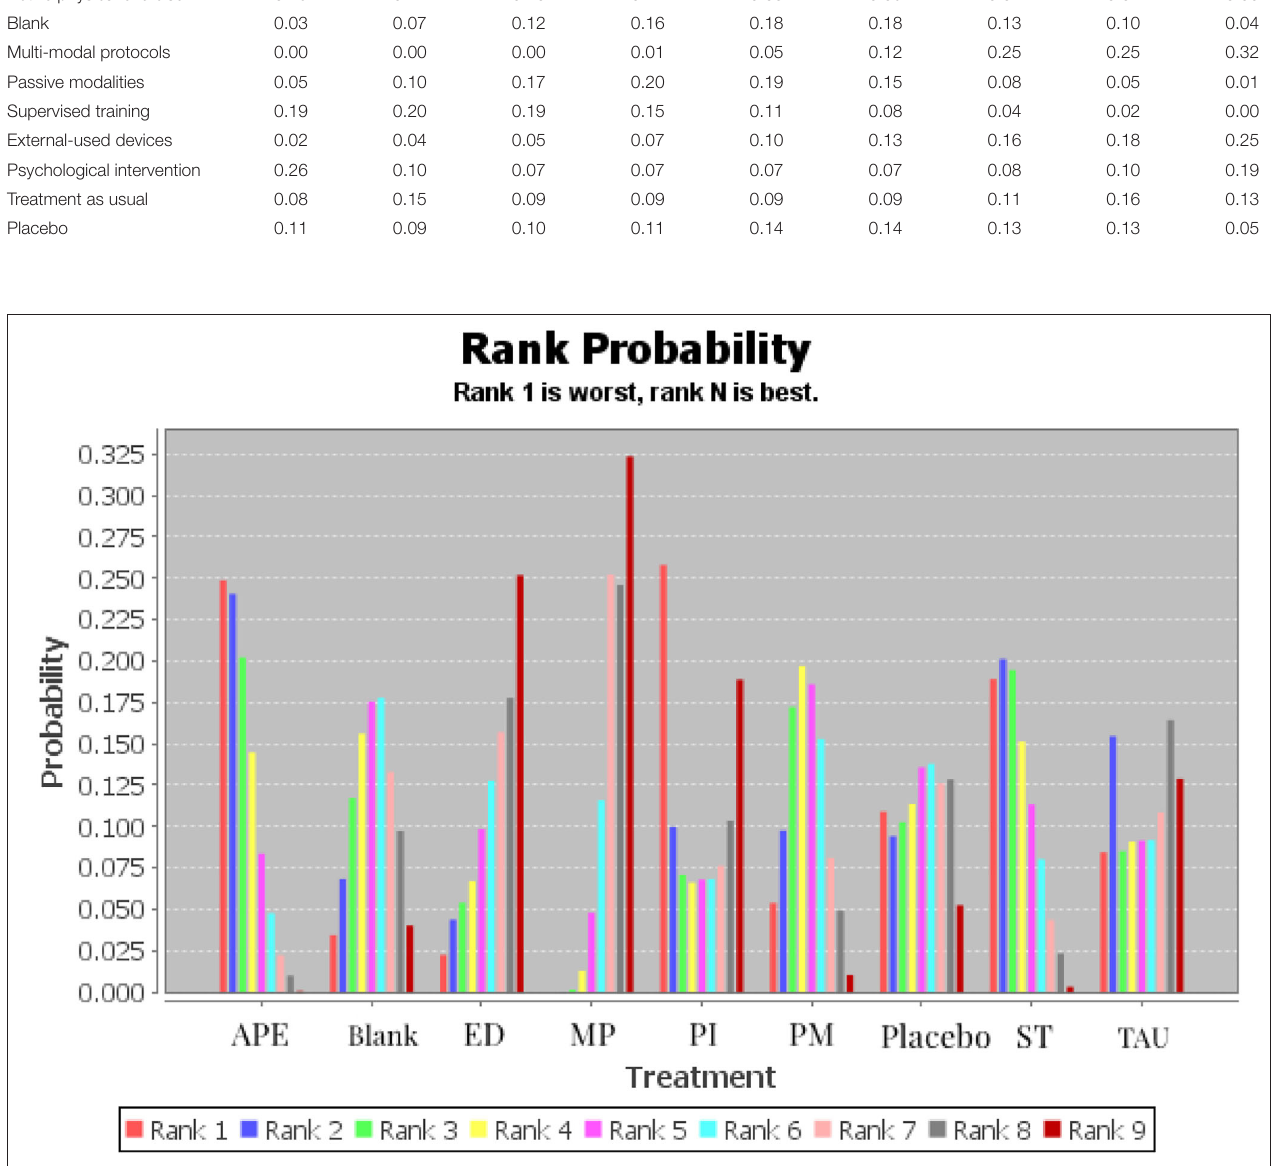
FIGURE 4 | Ranking of measures and probabilities (APE, Active Physical Exercise; ST, Supervised training; PI, Psychological Intervention; MP, Multi-modal Protocols; PM, Passive Modalities; ED, External-used Devices; TAU, Treatment as